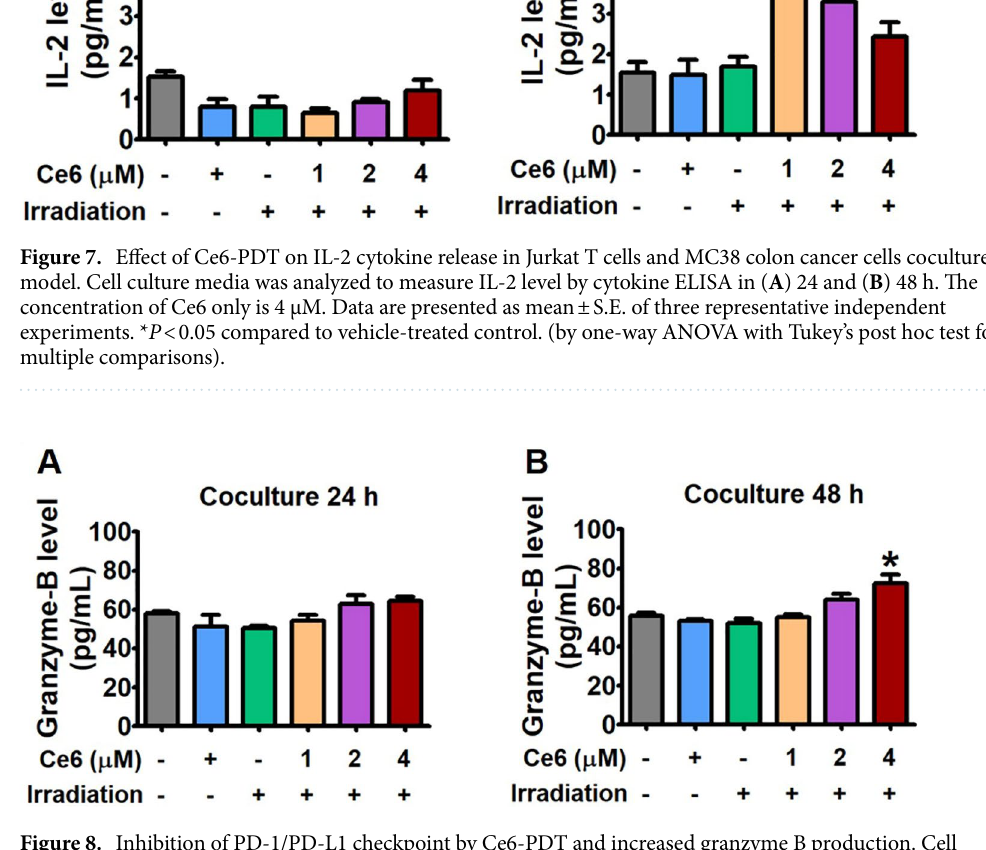
Figure 8. Inhibition of PD-1/PD-L1 checkpoint by Ce6-PDT and increased granzyme B production. Cell culture media was analyzed to measure granzyme level by cytokine ELISA in ( A ) 24 and ( B ) 48 h. The concentration of Ce6 only is 4 μΜ. Data are presented as mean ± S.E. of three representative independent experiments. * P < 0.05 compared to vehicle-treated control. (by one-way ANOVA with Tukey’s post hoc test for multiple